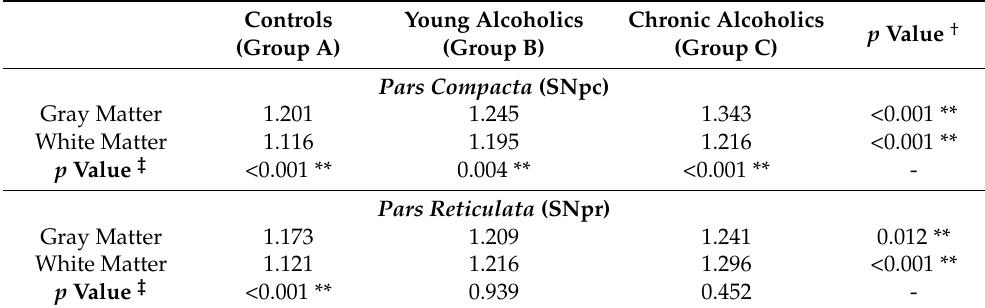
Table 4. Inter-group and intra-group comparisons of the differences in the grades of integrity based on the expression of collagen-IV in the BM of microvessels in the SN region (shown by weighted average). Controls Young Alcoholics Chronic Alcoholics p Value † (Group A) (Group B) (Group C) Pars Compacta (SNpc) Gray Matter 1.201 1.245 1.343 <0.001 ** White Matter 1.116 1.195 1.216 <0.001 ** p Value ‡ <0.001 ** 0.004 ** <0.001 ** - Pars Reticulata (SNpr) Gray Matter 1.173 White Matter 1.121 1.216 <0.001 ** <0.001 ** 0.939 0.452